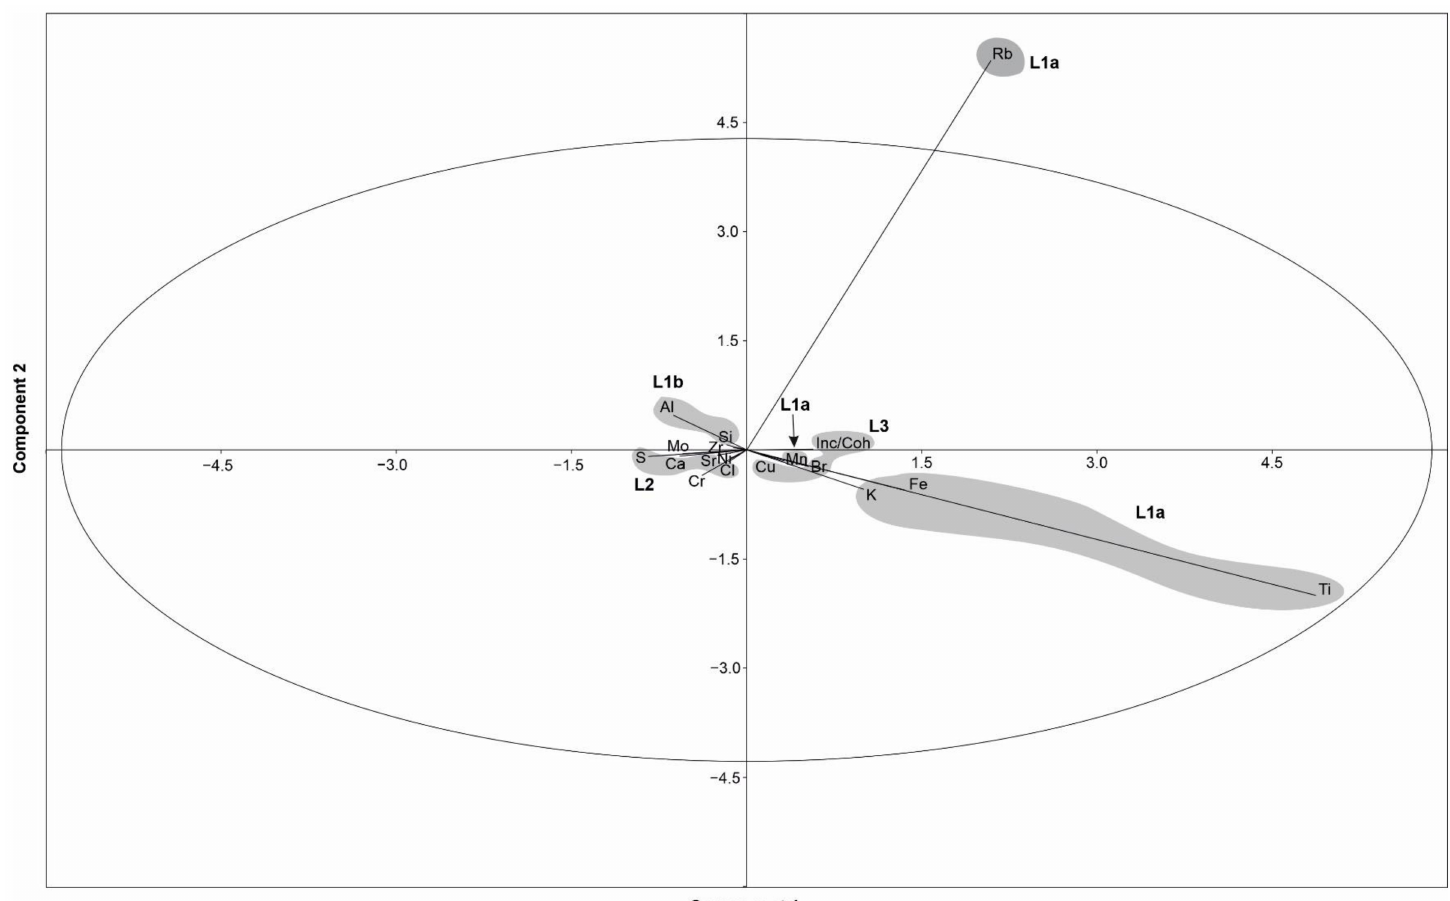
Figure 6. PCA biplot illustrating groupings of the variables associated with the littoral cores from Lake Chiprana. Ellipse represents the 95% confidence ellipse and shaded areas represent element